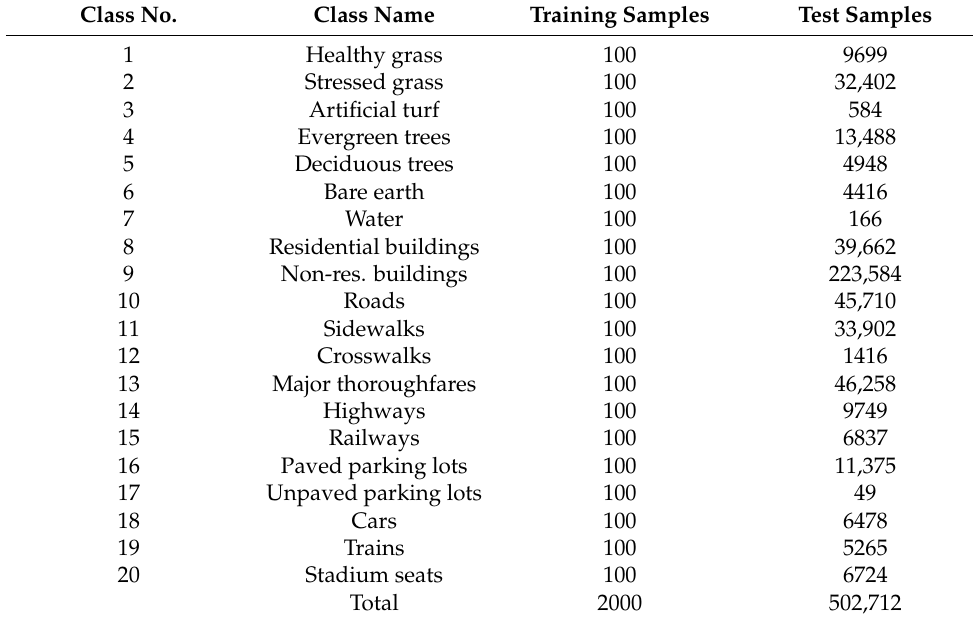
Table 2. The number of training and test samples used in the Houston 2018 dataset. Class No.